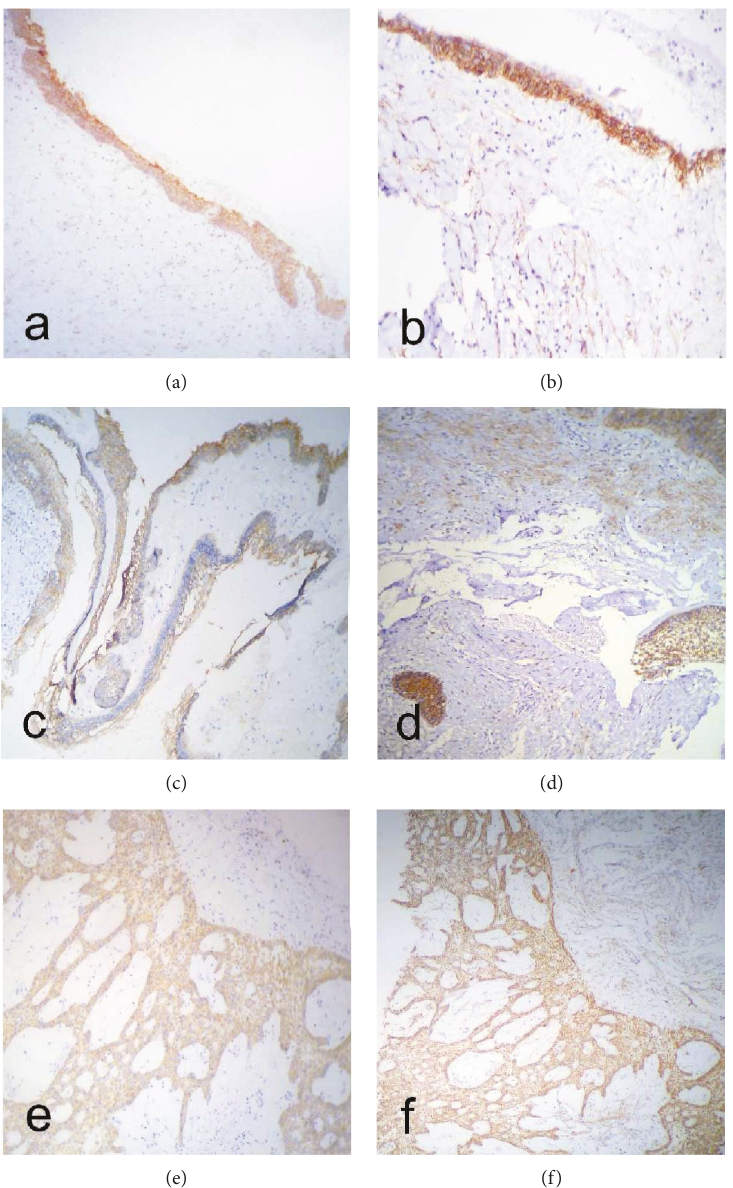
Figure 2: Ameloblastomas in which the rates of E-cadherin and syndecan-1 expression were evaluated. (a) E-Cadherin expression in a luminal/intraluminal ameloblastoma. (b) Expression of epithelial and stromal syndecan-1 in a luminal/intraluminal ameloblastoma. (c) Expression of E-cadherin in a unicystic ameloblastoma with mural invasion. (f) Membrane expression intensity of E-cadherin in a unicystic ameloblastoma with mural invasion. (d) Expression of epithelial and stromal syndecan-1 in a unicystic ameloblastoma with mural invasion. (e) Expression of E-cadherin in a solid/multicystic ameloblastoma. (f) Epithelial and stromal expression of syndecan-1 in a solid/multicystic